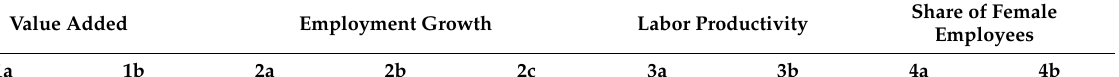
Table 7. Fixed-effects